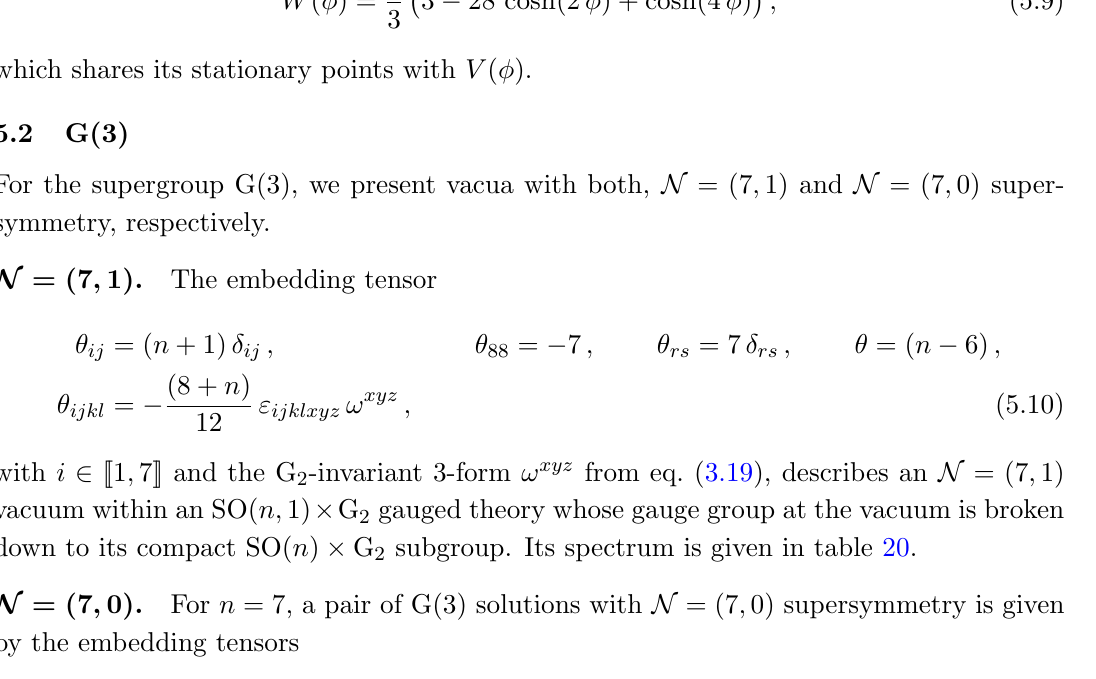
Figure 1. Potential for the 1-scalar truncation (5.5) of the theory with gauge group SO(8) The vacuum at the scalar origin (cid:30) = 0 preserves full